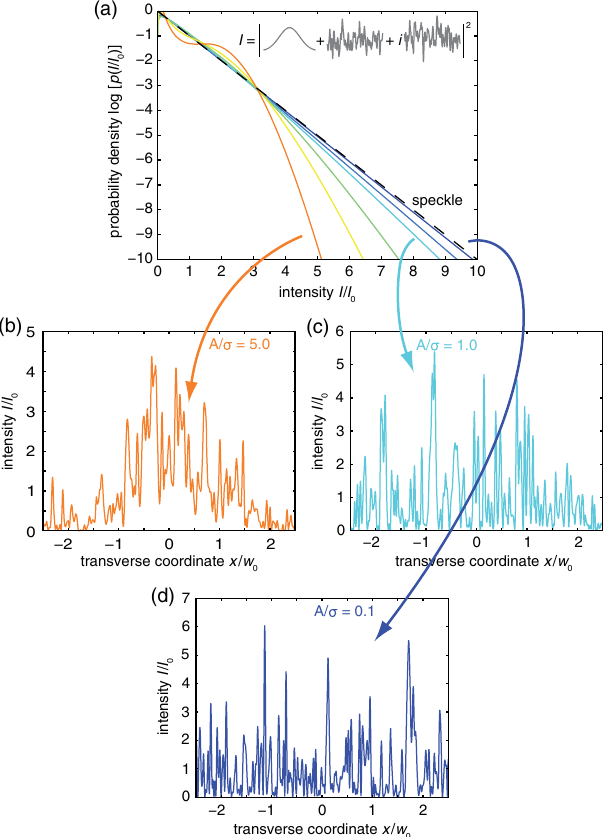
FIG. 13. Influence of a Gaussian background on the intensity statistics. (a) Probability density function p ð I=I 0 Þ , where I ¼ j E þ E þ iE j 2 . A pronounced Gaussian background 1 real imag tends to suppress extreme events, if the profile is normalized with respect to its mean intensity I 0 in an interval x ∈ ½ − 2 . 5 w 0 ; 2 . 5 w 0 (cid:2) , where w 0 is (half) the width of the squared modulus of the Gaussian field profile. For an increasing ratio of the amplitude A of the Gaussian background and the standard deviation σ of the normally distributed random variables, the tail of the probability density drops down significantly already at small intensities. (b) – (d) Exemplary numerical realizations of intensity profiles for A= σ ¼ 5 . 0 (b), A= σ ¼ 1 . 0 (c), and A= σ ¼ 0 . 1